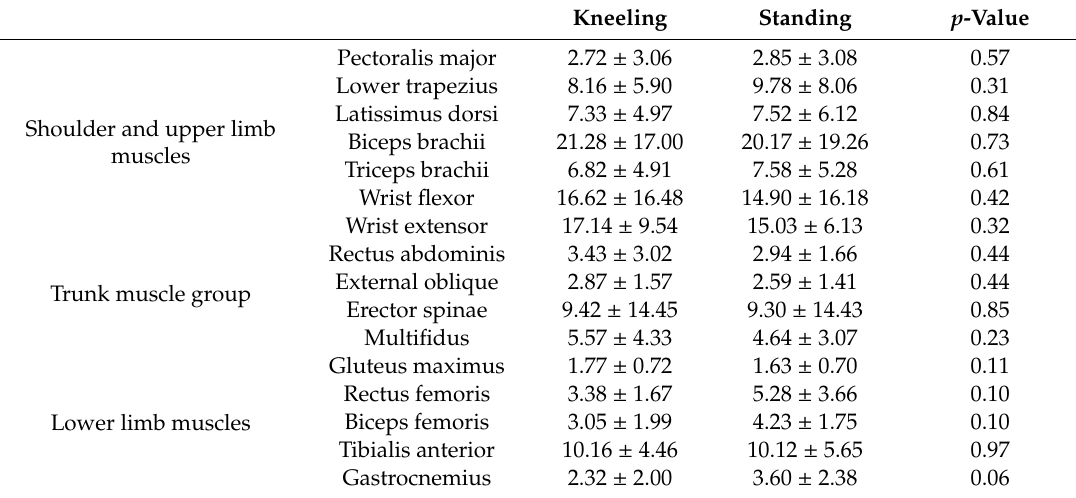
Table 2. Average activation of each muscle in di ff erent postures ( µ V). Kneeling Standing p